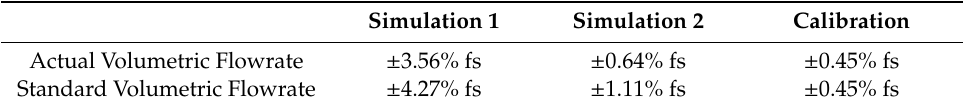
Table 13. Uncertainty of the actual and standard volumetric